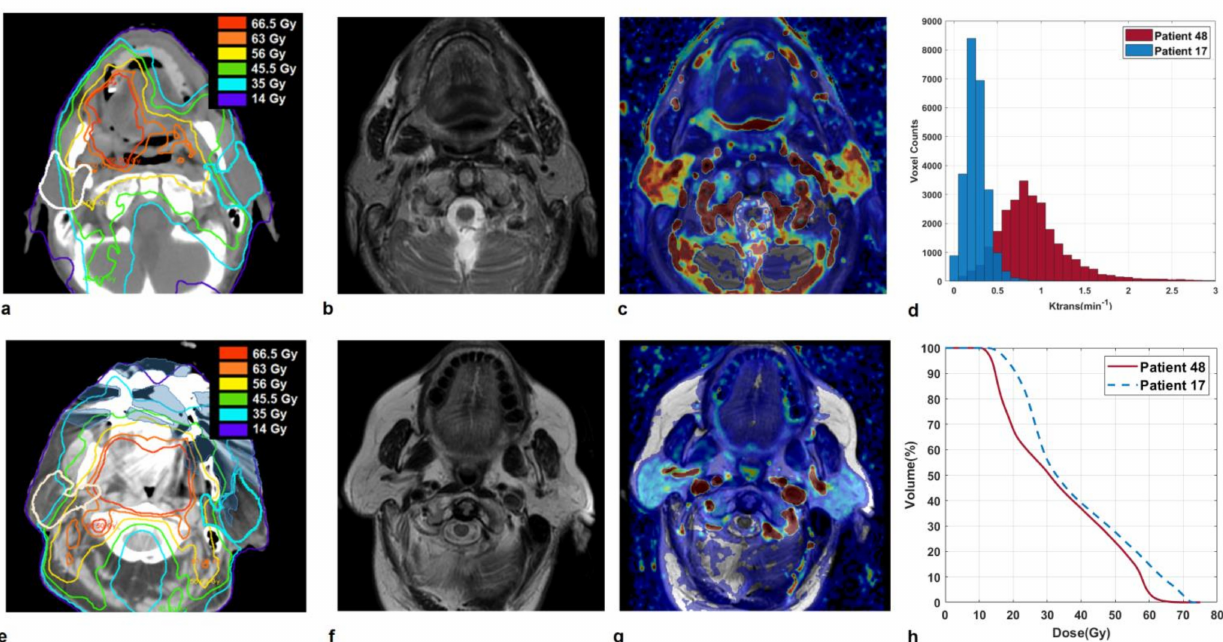
Figure 2. Sections of parotid glands in a 68-year-old man affected by a tonsil carcinoma (Patient 48) on axial CT image with overlaid isodose levels and parotid contours ( a ); the corresponding axial T2-weighted image ( b ) and map of K trans ( c ) which indicates highly vascularized glands. Analogously, sections of parotid glands in a 75-year-old woman affected by a soft palate carcinoma (Patient 17) on axial CT image with overlaid isodose levels and parotid contours ( e ); the corresponding axial T2-weighted image ( f ) and map of K trans ( g ) which shows moderately perfused glands. K trans histograms ( d ) and dose-volume histograms ( h ) of both parotids, for Patient 48 and 17 in comparison. Patient 48, who developed grade 1 XER 12 , had much more vascularized parotids glands than Patient 17, who experienced grade 2 XER 12 (median K trans = 0.93 versus 0.19 min − 1 ). He received little lower doses to parotids (D mean /V65 = 33.3 Gy/0.4% versus 38.1 Gy/8.5%) but showed much lower in-treatment XQ scores, compared to patient 17 (XQ-Int mid = 33.2 versus 82.9,